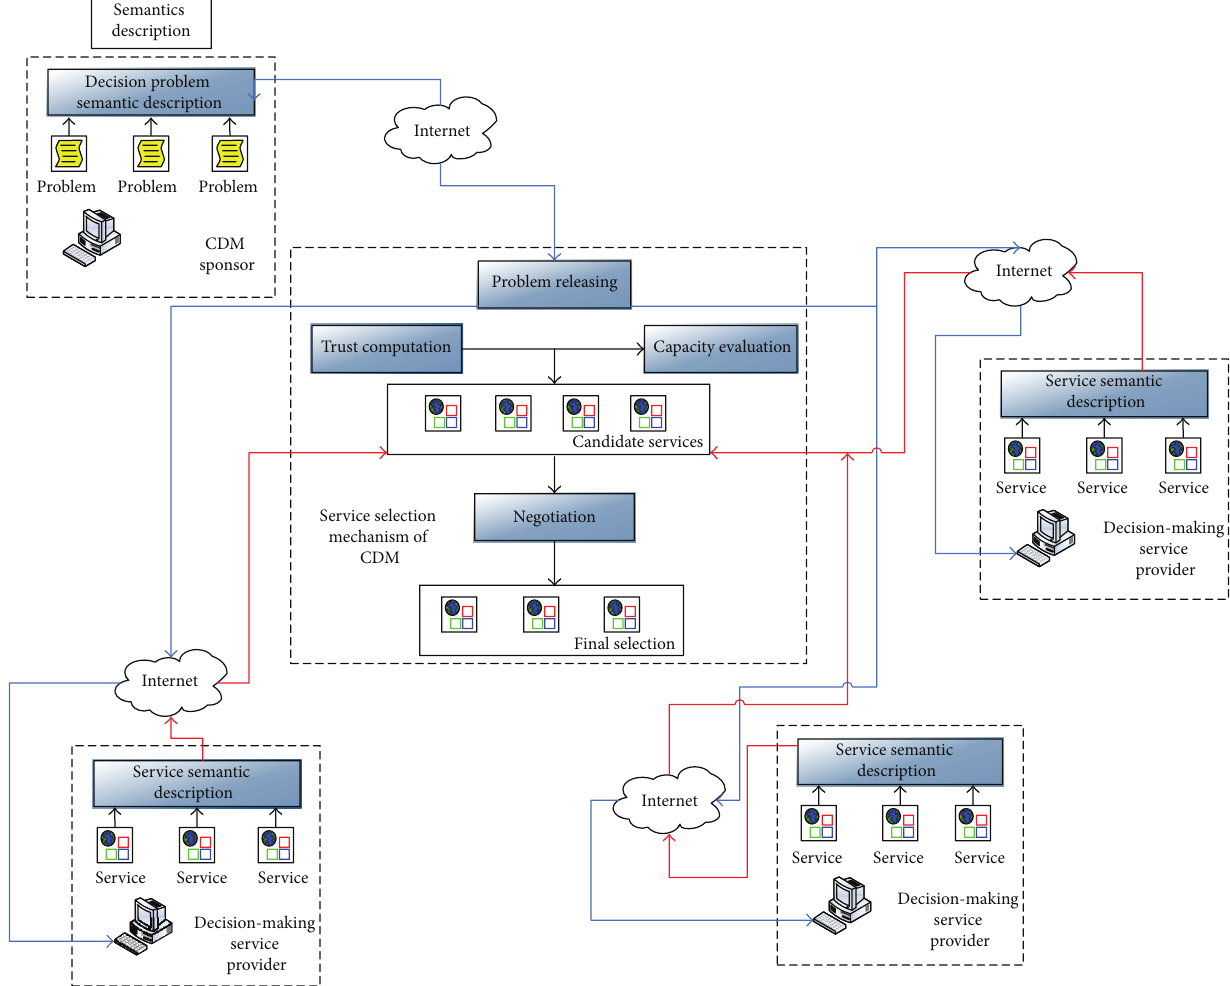
Figure 1: Our DMSP selection mechanism for